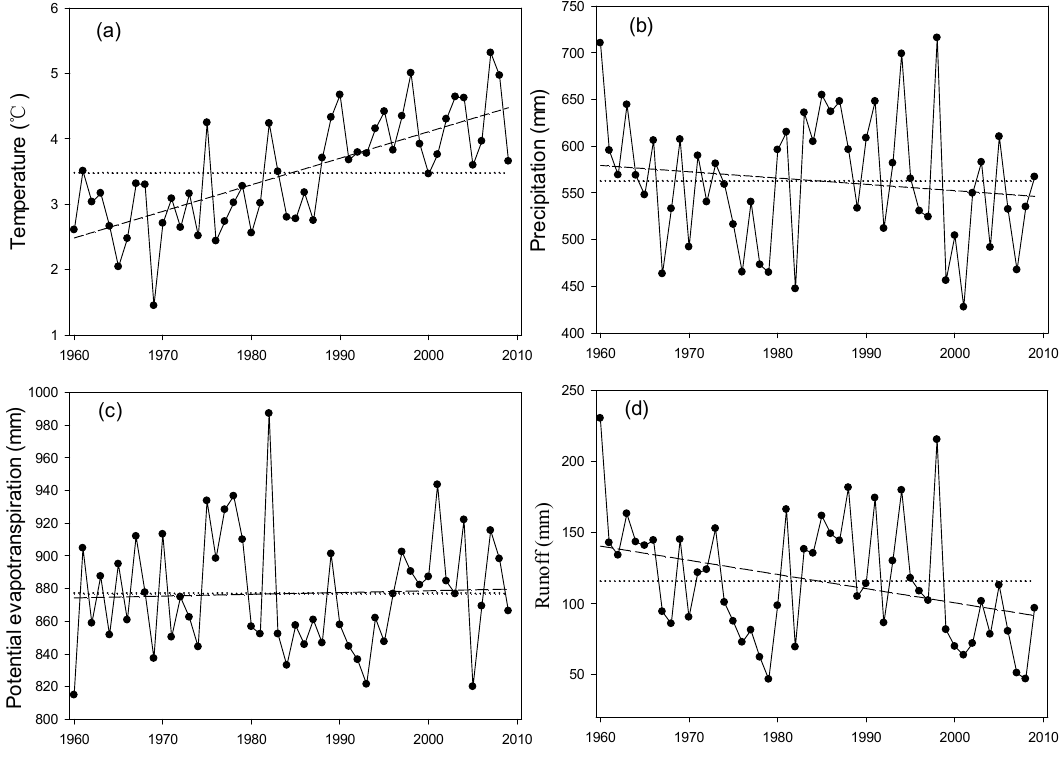
Figure 2. Annual values (dots) and trends (dashed line) of mean temperature ( a ); precipitation ( b ); potential evapotranspiration (PET) ( c ); and runoff ( d ) for 1960–2009 in the Songhua River Basin, Northeast